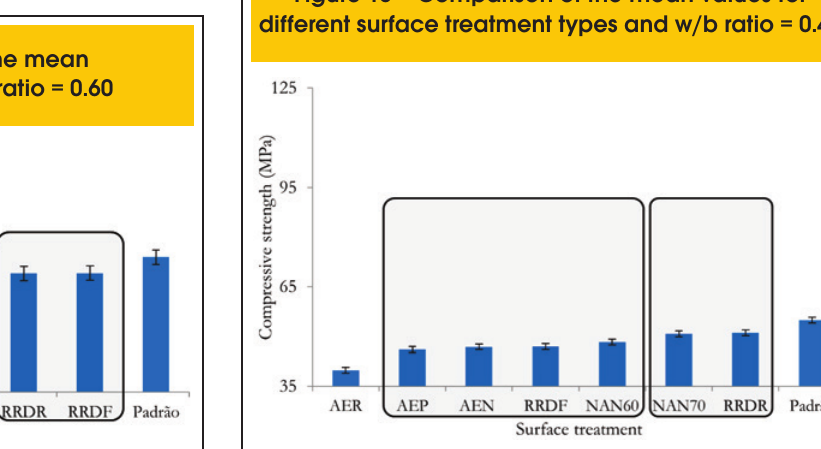
Figure 8 – Comparison of the mean values for concrete with w/b ratio = 0.60